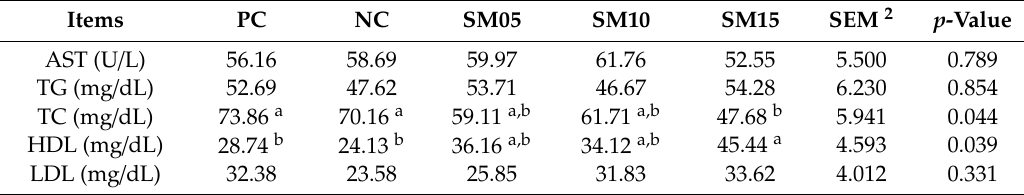
Table 4. E ff ect of spent mushroom ( C. militaris ) on metabolic profiles in weaning pigs 1